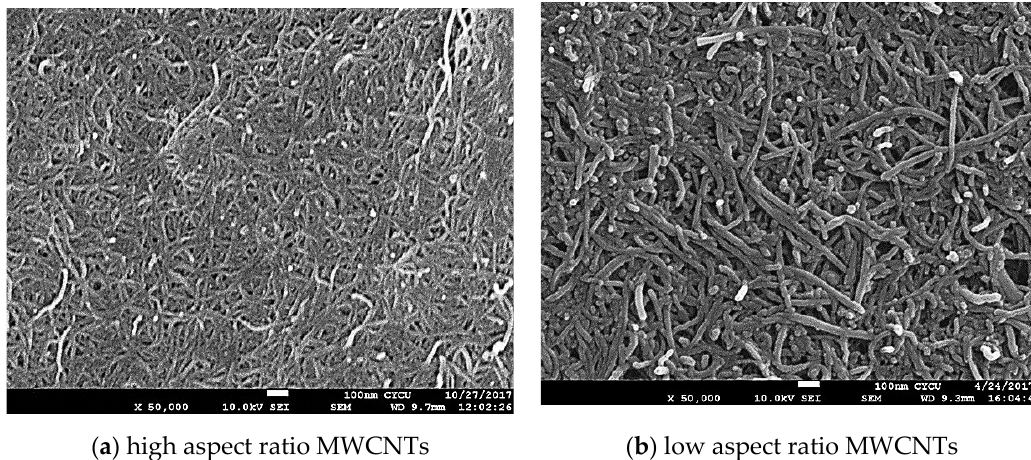
Figure 5. Surface morphology of buckypaper. ( a ) buckypaper composed of high aspect ratio MWCNTs ( b ) buckypaper composed of low aspect ratio MWCNTs.